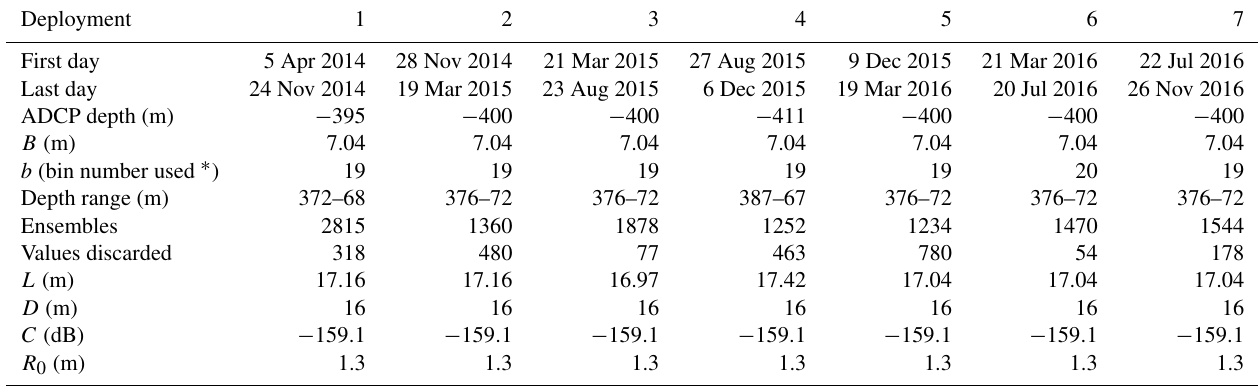
Table 1. Deployment characteristics: the depth − 400m is a nominal depth, while − 395 and − 411m are mean values from the continuous record of the ADCP pressure sensor; the blank is the distance between the transducer and the first bin; deployments 1 and 4 had a slow subsidence of 50cm in 234d and 30cm in